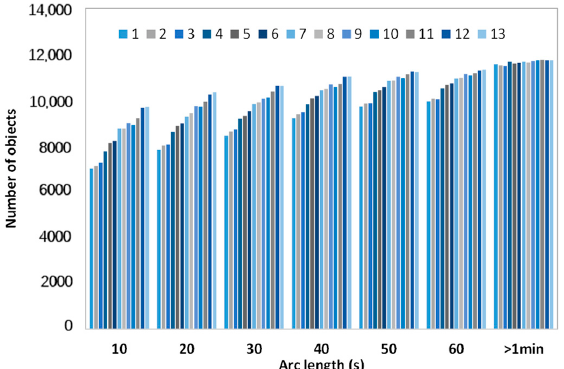
Figure 10. The distribution of observable objects with an arc length in the different constellation configurations.